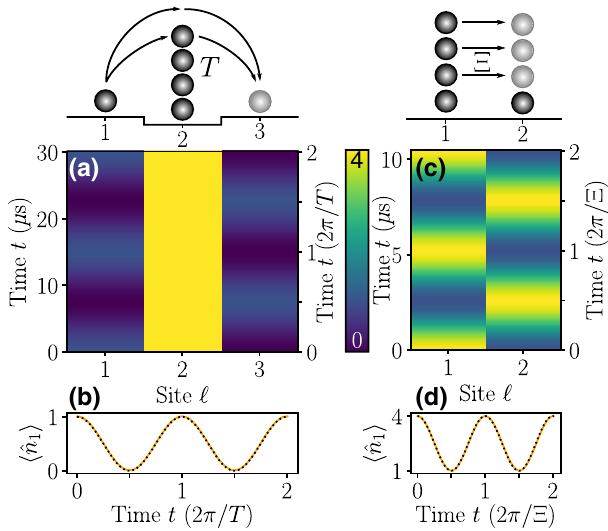
FIG. 3. Single-boson tunneling and boson-quasiparticle exchange. (a),(c) The local occupations (cid:2)ˆ n (cid:3) (cid:3) as a function of the site index (cid:3) and time t . (b),(d) The occupation of the site (cid:3) = 1 as a function of time t , simulated using the full Hamiltonian of Eq. (1) (solid yellow) and the effective Hamiltonian of either Eq. (18) (b) or Eq. (20) (d) (dotted black). The initial state is | 140 (cid:3) in (a)–(b) and | 41 (cid:3) in (c)–(d). Note the different time scales involved in the two processes, one determined by the tunneling rate T and the other by the exchange rate (cid:9)